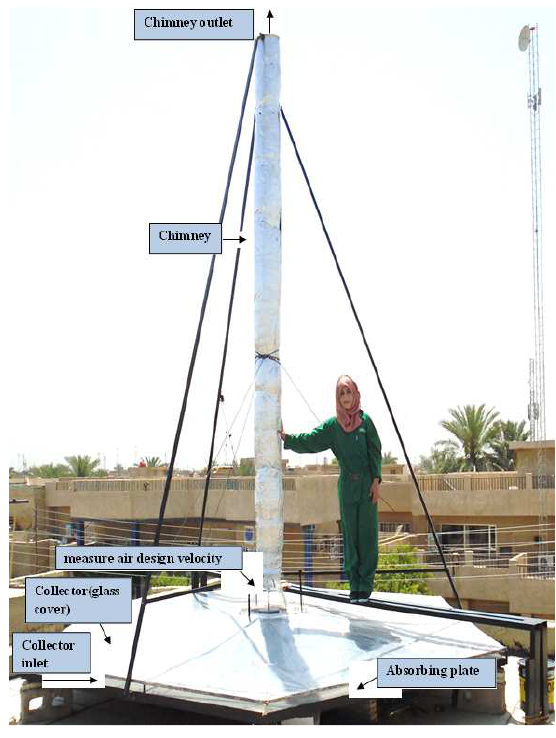
Fig. 6. Scale model of solar chimney power plant.